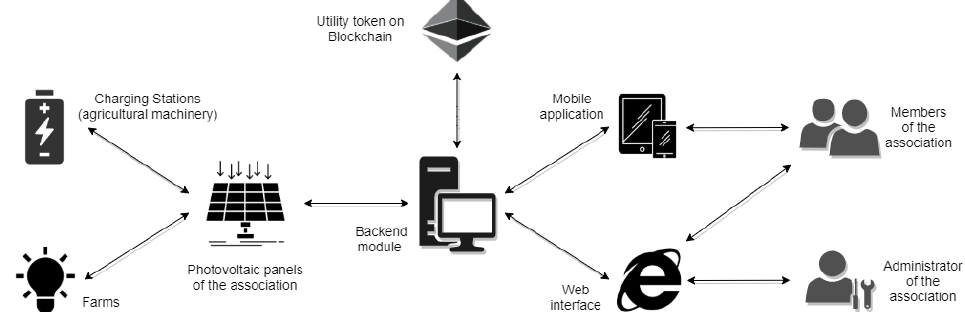
Figure 4. Digital Figure 4. Digital Platform.